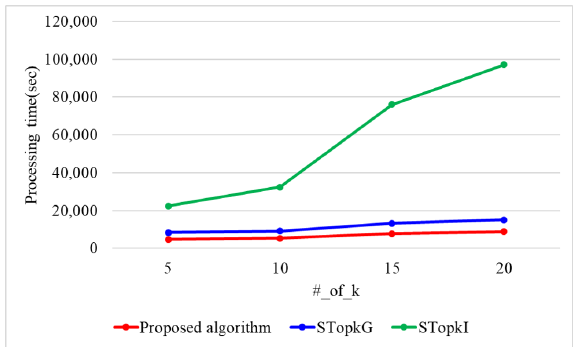
Figure 10. Processing time with a varying number of